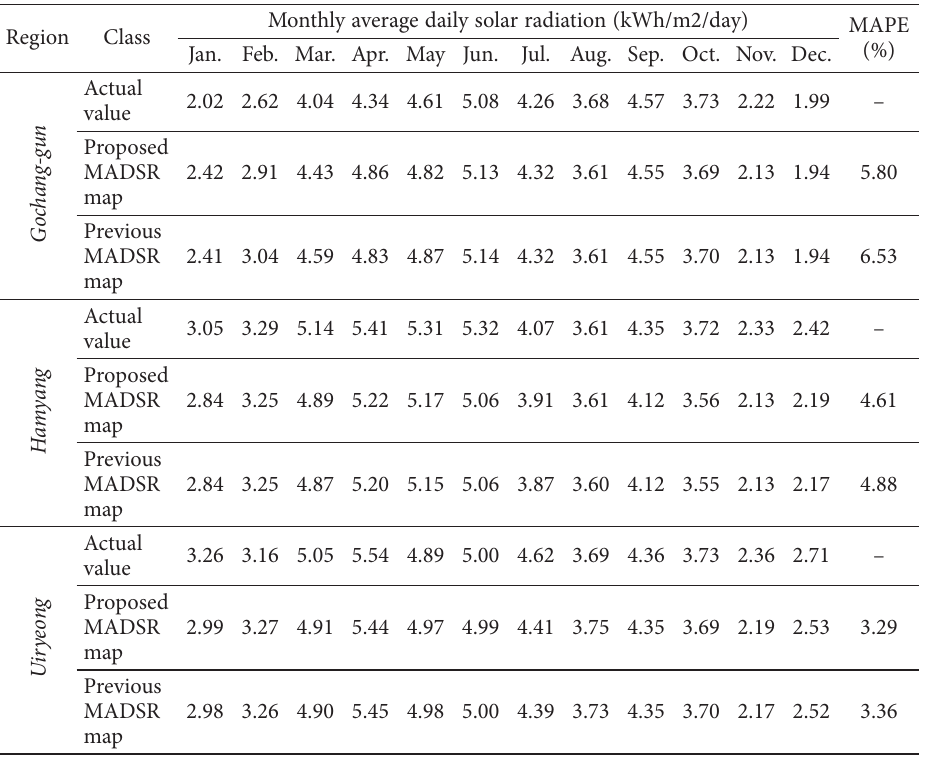
Table 4. Comparison of the estimation accuracy of the proposed and previous MADSR maps (three target locations for validation)